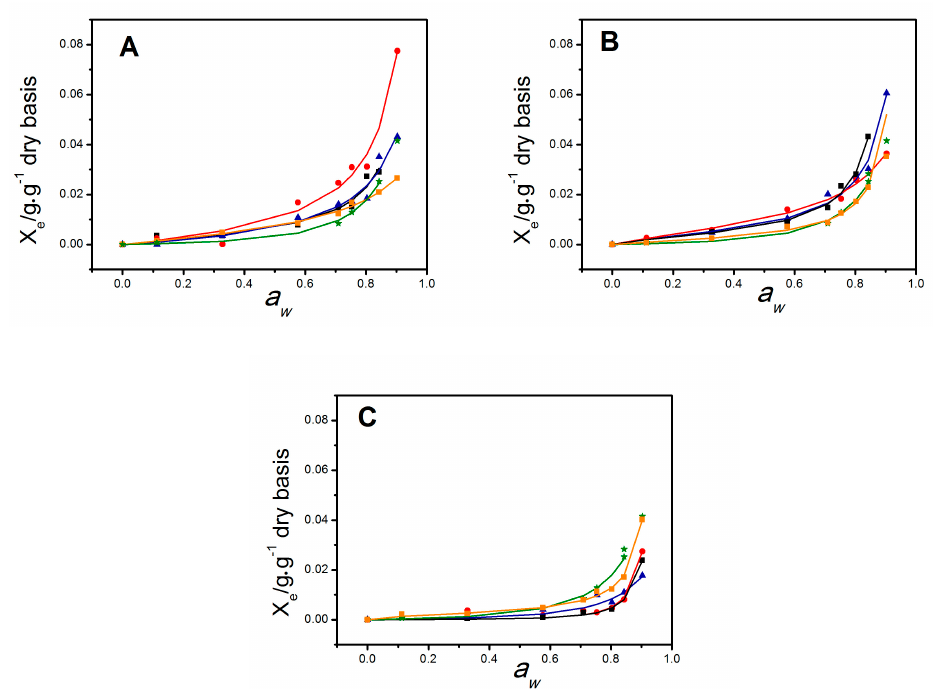
Figure 2. Experimental sorption data—equilibrium moisture content (X e ) vs. water activity (a w ). Dry basis symbols and the corresponding fitting (solid lines) using the GAB model for the NS, S, and NS/S biobase chitosan films. NS (green stars, all panels) and S (orange squares, all panels). The following NS/S ratios were studied for each system: 7:3 (black squares), 1:1 (red circles) and 3:7 (blue triangles) in all panels; nanosized chitosans were represented in panel A (S 5min ), panel B (S 15min ), and panel C (S 30min ). Films were cut into 25 × 25 mm 2 pieces, dried under vacuum at 60 ◦ C for 40 h and placed at 25 ◦ C into hermetic containers with equilibrium water activities ( a W ) ranging from 0.1 to 0.9.